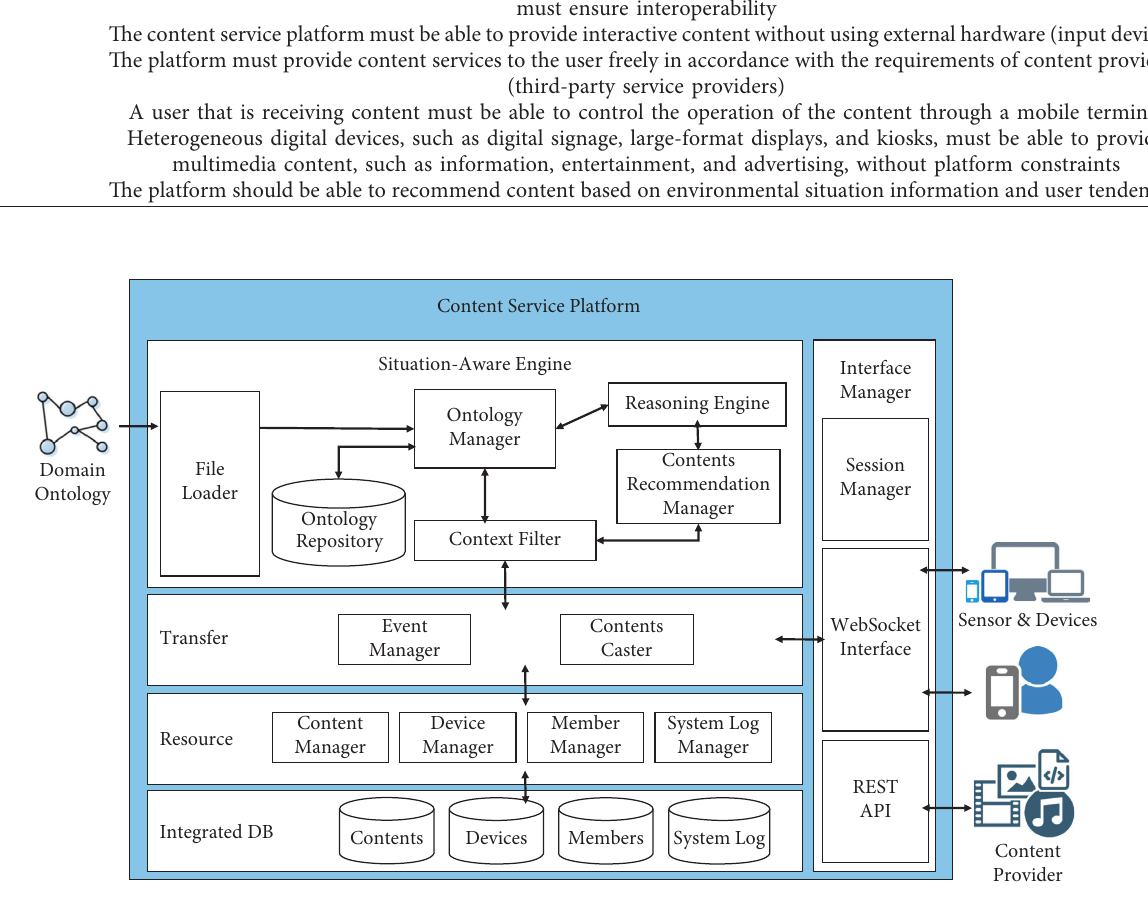
Figure 1: Architecture of the content service